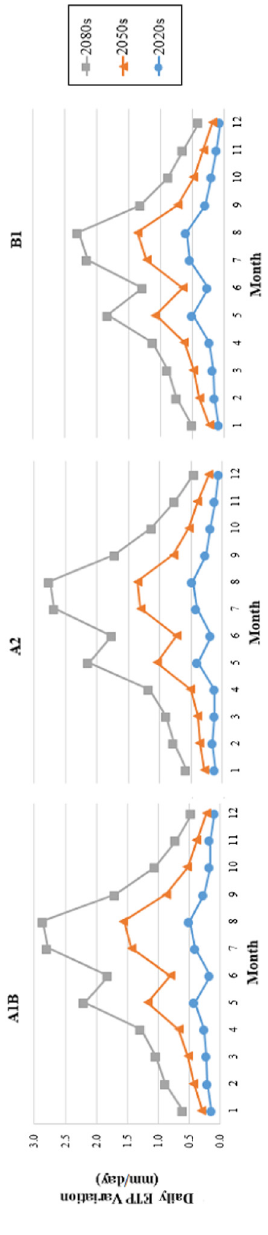
Figure 4. Daily ETP changes compared with the observed period